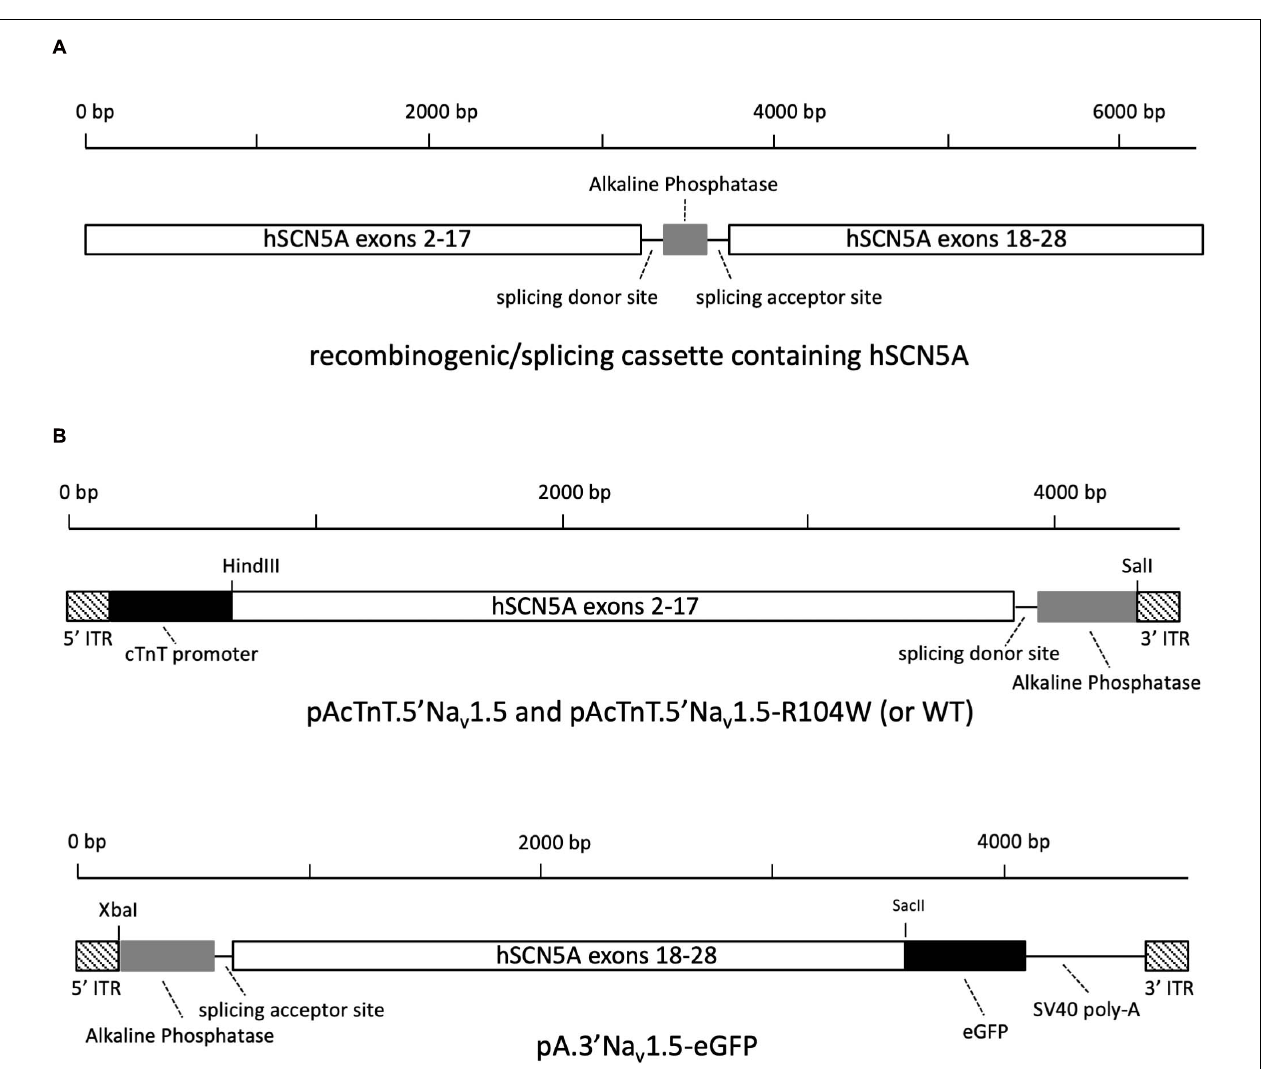
FIGURE 1 | Design of 5 (cid:48) and 3 (cid:48) AAV-hNa v 1.5 expression vectors. (A) The recombinogenic/splicing cassette inserted at the junction between exons 17 and 18 of SCN5A cDNA contains splicing donor and acceptor sequences from the chimeric intron of pCI vector and a reverse-complementary 288 bp sequence from human placental alkaline phosphatase. (B) Schematic representation of plasmids pAcTnT.5 (cid:48) Nav1.5-R104W and pA.3 (cid:48) Nav1.5-eGFP cloned to produce two distinct trans -splicing AAV